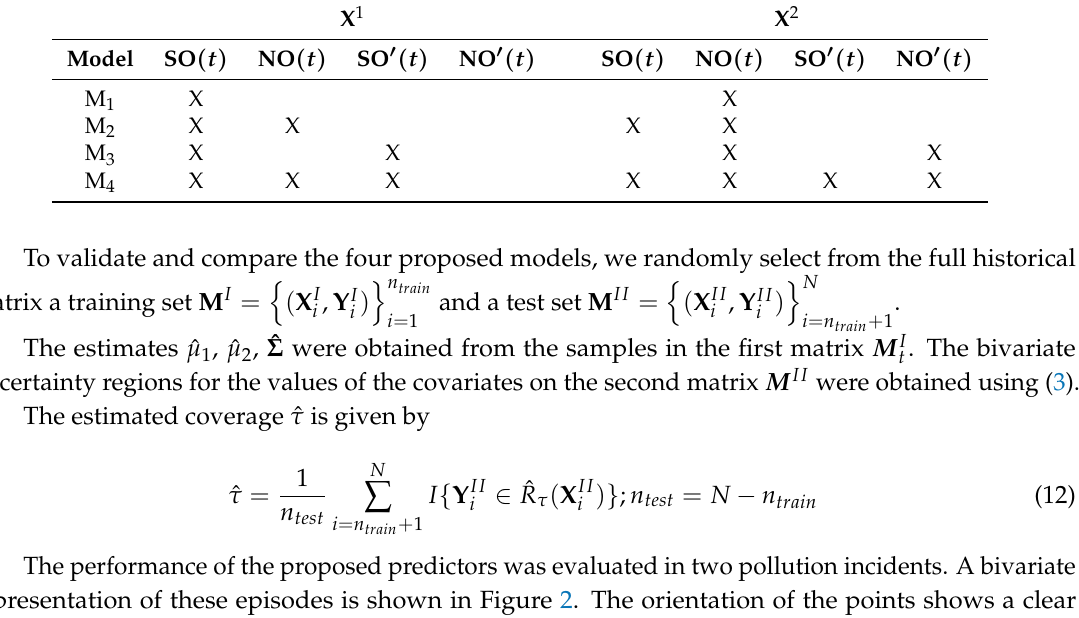
Table 1. Selected models from equation in (11) . Cross X indicates the covariates included in each of the four considered models. The derivatives of the functions are indicated with a single quote. X 1 X